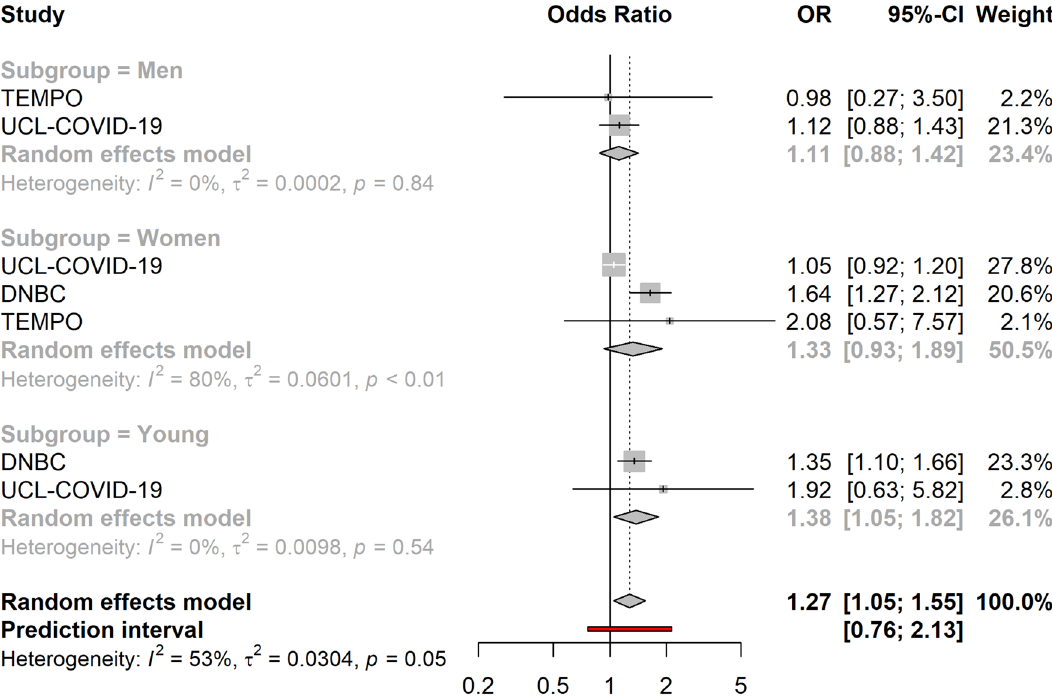
Figure 5. Association between living alone (vs. living with others) and low life satisfaction (N = 40,965). The cohort-specific estimates and 95% confidence intervals were obtained using binary logistic regression models. Age, educational attainment, gender, previously diagnosed chronic disease status and presence of previously diagnosed mental illness were used a covariates. In addition, the models included mutual adjustment for the other housing exposures. 95% CI 95% confidence interval, OR odds